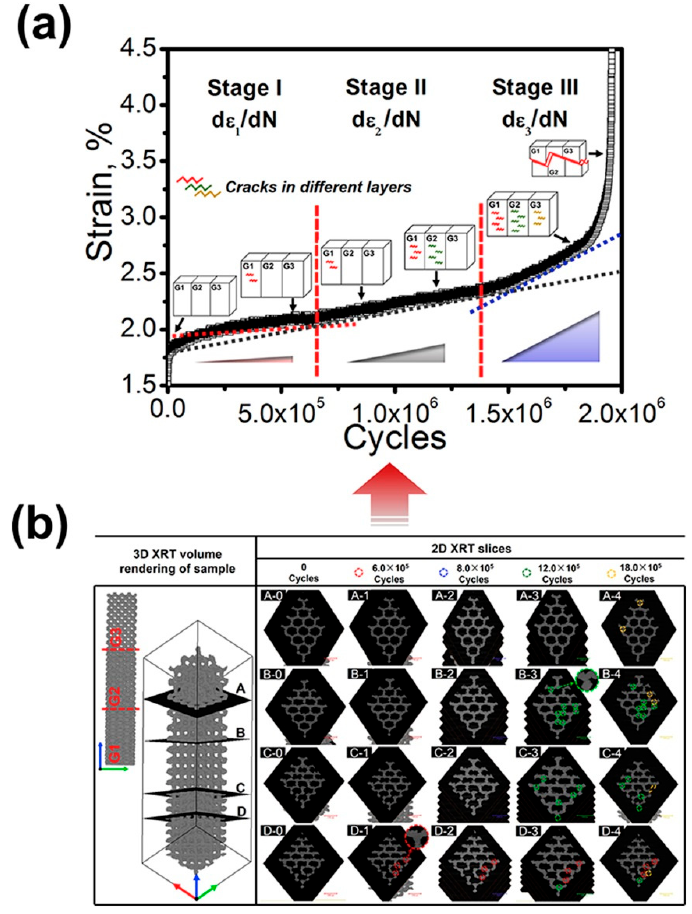
Figure 2. ( a ) strain-cycle curves of the graded mesh, ( b ) XRT images of the graded meshes which are corresponding to the arrow points shown in ( a ). 2D slices A, B, C, and D are located at the G3, G2, and G1 part is shown specifically sitting in the volume rendering of the sample. The numbers 0, 1, 2, 3, and 4 are in accordance with the 5 arrow point, respectively. The colored dash cycles in ( b ) indicate the sites of the cracks observed at each arrow point [101].